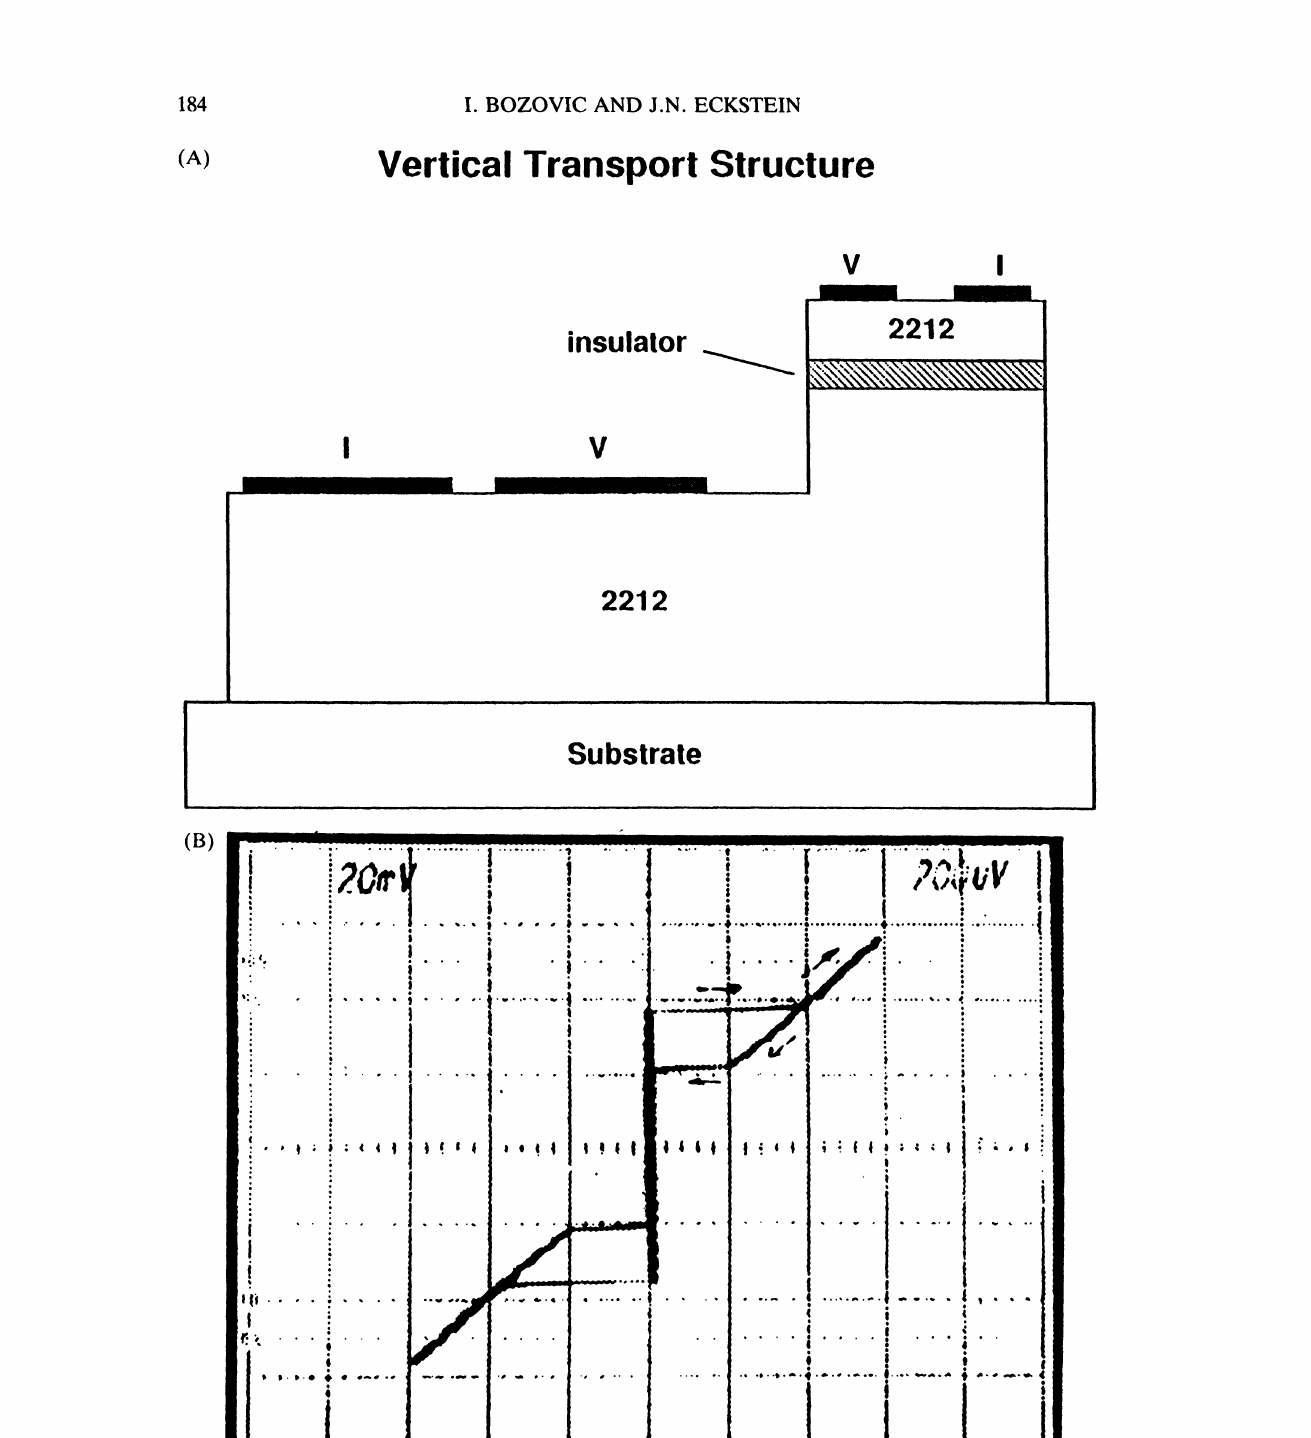
FIGURE 5 (A) A schematic representation of a trilayer Josephson junction device. (B) Current- voltage characteristic of a trilayer Bi-Sr-Ca-Cu-O junction fabricated by ALL-MBE. (C) The same, for device illuminated with 17.9 GHz microwave